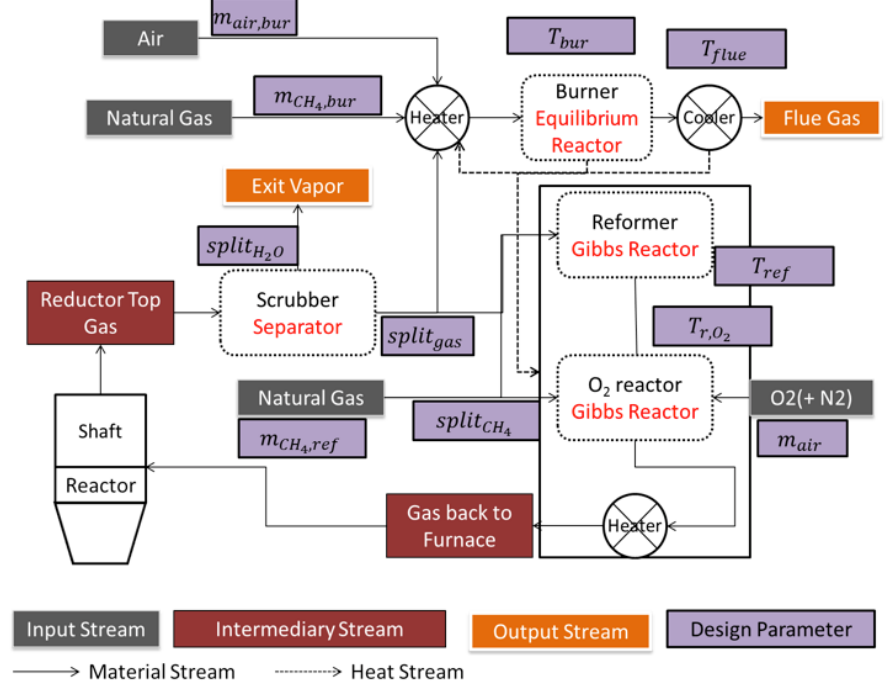
Figure 9. Whole plant Aspen Plus model, with gas recirculation and key design variables.